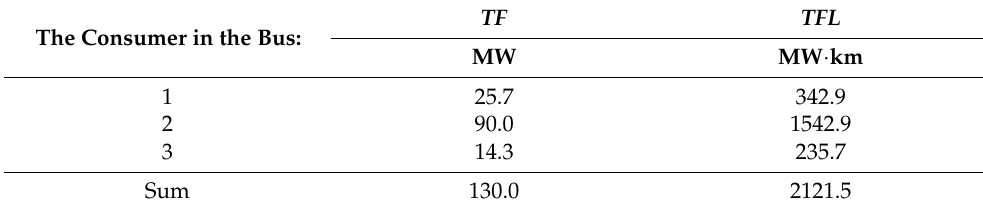
Table 7. The degree of network utilization by consumers connected to the two-sided supplied